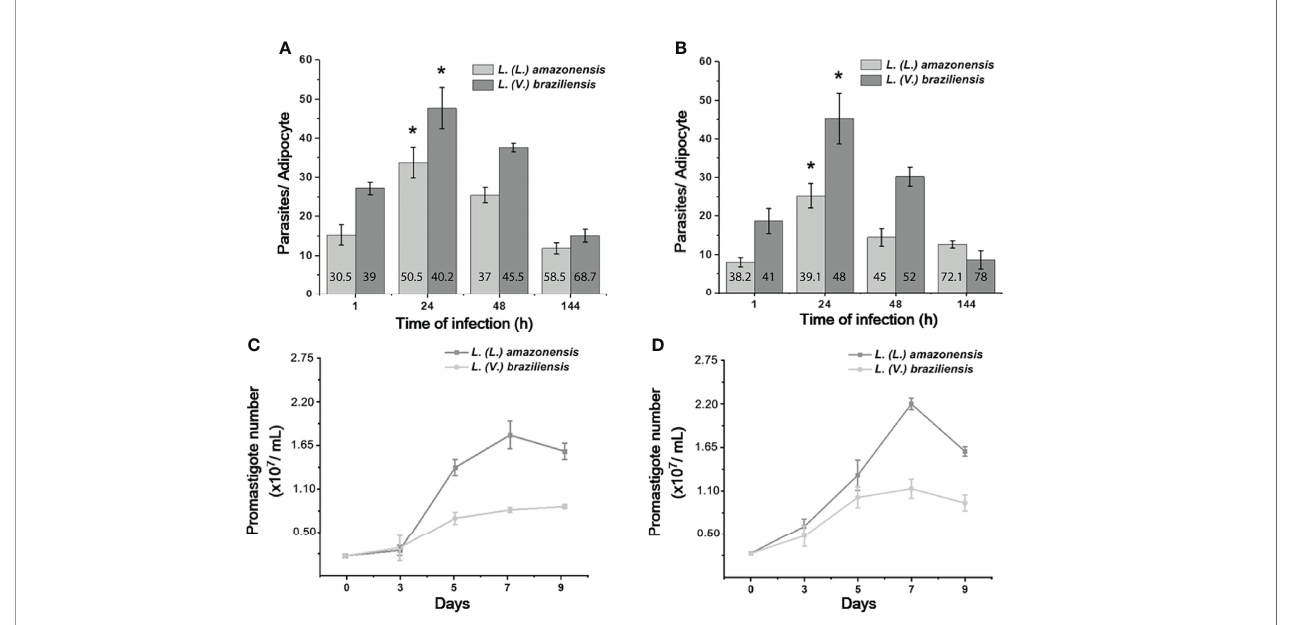
FIGURE 4 | In vitro kinetics of Leishmania intracellular growth after 3T3-Ad infection, and parasite viability. The mean number of amastigotes per 3T3-Ad ± standard deviation was determined after infection with promastigotes (A) or axenic amastigotes (B) and incubation for 1, 24, 48 and 144 h, for L. (L.) amazonensis and L. (V.) braziliensis . At least 100 3T3-Ad cells were counted per condition. Assays were performed in triplicate and the assays were repeated at least twice. Asterisks indicate a statistically signi fi cant difference ( p -value < 0.05) for each time point vs . 1 h (Student ’ s t test). Numbers in the bars indicate the mean of infected 3T3-Ad (%) per condition. (C, D) : Growth curves of parasites recovered from 3T3-Ad infections with promastigotes or amastigotes, respectively, after 144 h. Amastigote-promastigote differentiation was carried out as described in the ‘ Methods Section ’ and recovered parasites resuspended in M199 were kept at 25°C. On the 3rd day, promastigotes were observed, which grew exponentially until reaching the maximum density peaks around day 7. Experiments represent the mean of triplicates ± standard